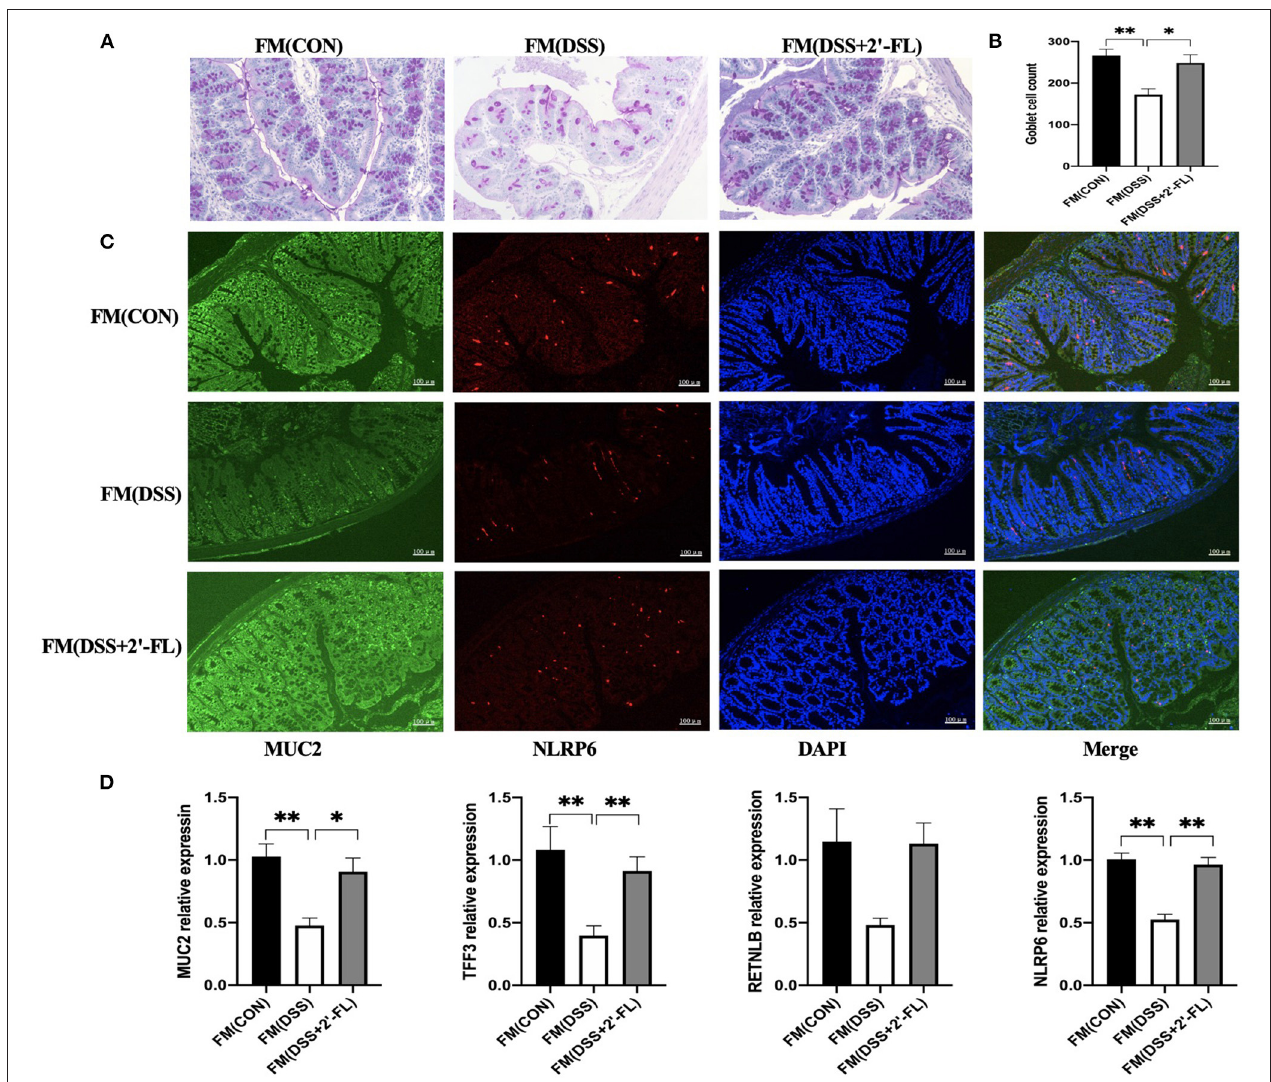
FIGURE 8 | FMT validates the role of microbiota regulated by 2 ′ -FL in protecting goblet cells and enhancing MUC2 secretion. (A) Representative periodic acid-Schiff (PAS)-stained distal colon sections showing goblet cells. Scale bar, 100 µ m; (B) The number of goblet cells in distal colon; (C) Representative fluorescent images of MUC2 (green) and NLRP6 (red) in colon tissue. (D) Quantitative RT-PCR showing expression of MUC2, TFF3, RETNLB and NLRP6, relative to GAPDH. Significance was determined using one-way ANOVA and expressed as mean ± SEM. ( n = 6 for each group). * p < 0.05; ** p <